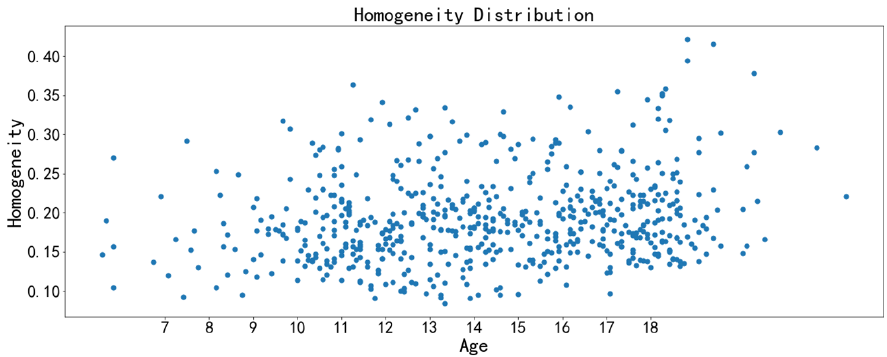
Figure 11. Scatter diagram between homogeneity with chronological age (females).